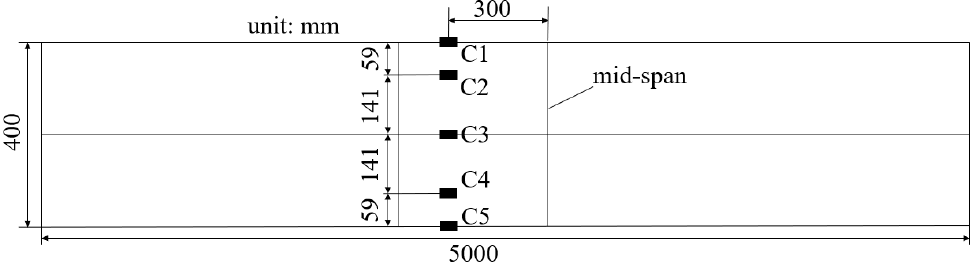
Figure 5. The arrangement of strain gauges.